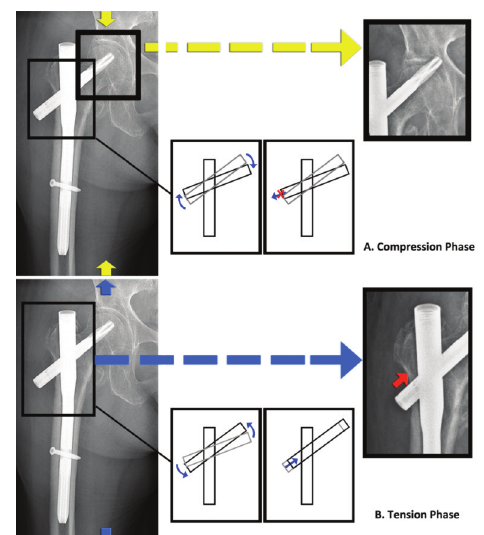
Diagrammatic representation of postulated mechanism Fig. 12: behind the medial migration phenomenon with repeated loading-unloading at the hip joint.